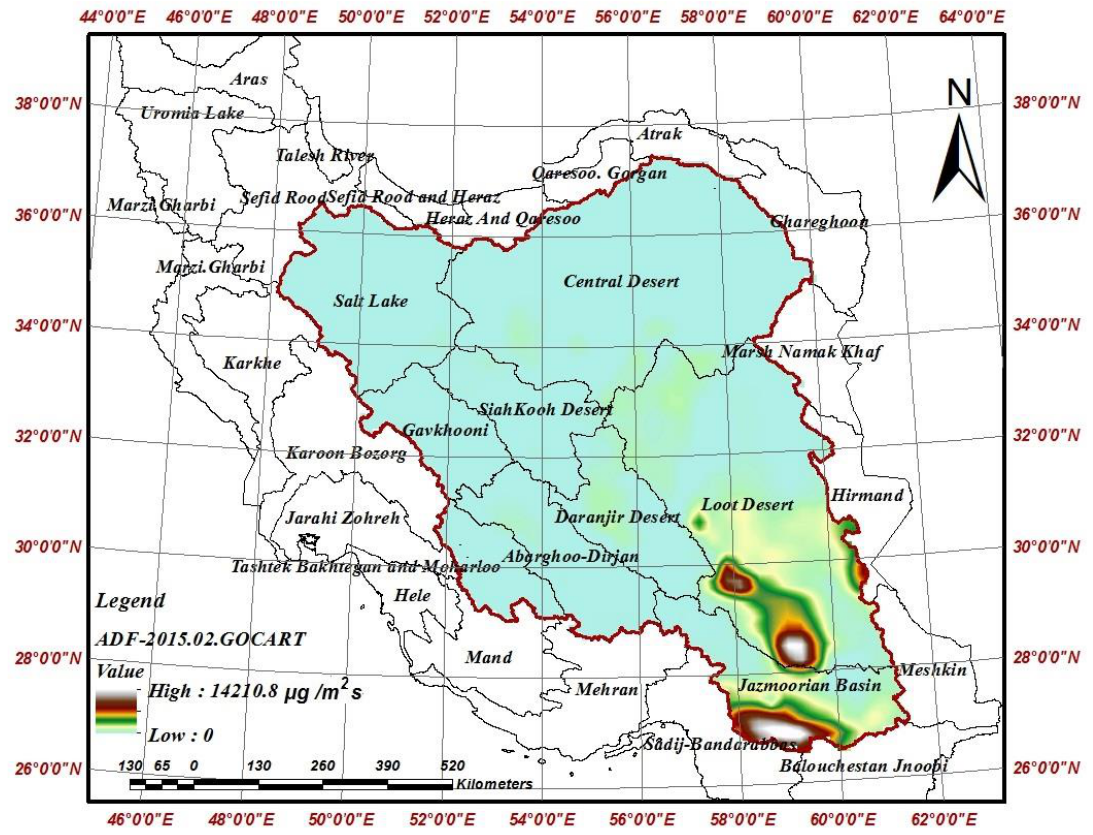
Figure 13. Average Spatial Pattern of Storm Dust Flux ( µ g / m 2 s) on 21 February 2015 with GOCART Scheme.